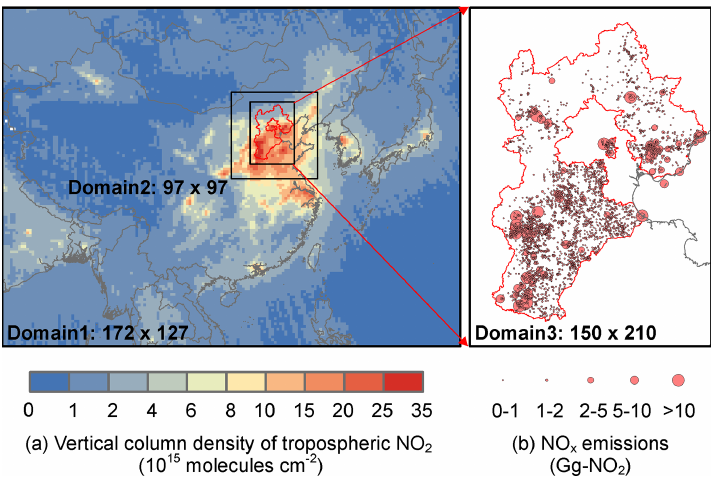
Figure 1. Triple-nested domains of the CMAQ simulation: (a) spatial extent of triple-nested domains with OMI (ozone monitoring instrument)-derived NO 2 column densities (Boersma et al., 2011) in background, (b) domain 3 with NO x emissions from point sources in HB-EI